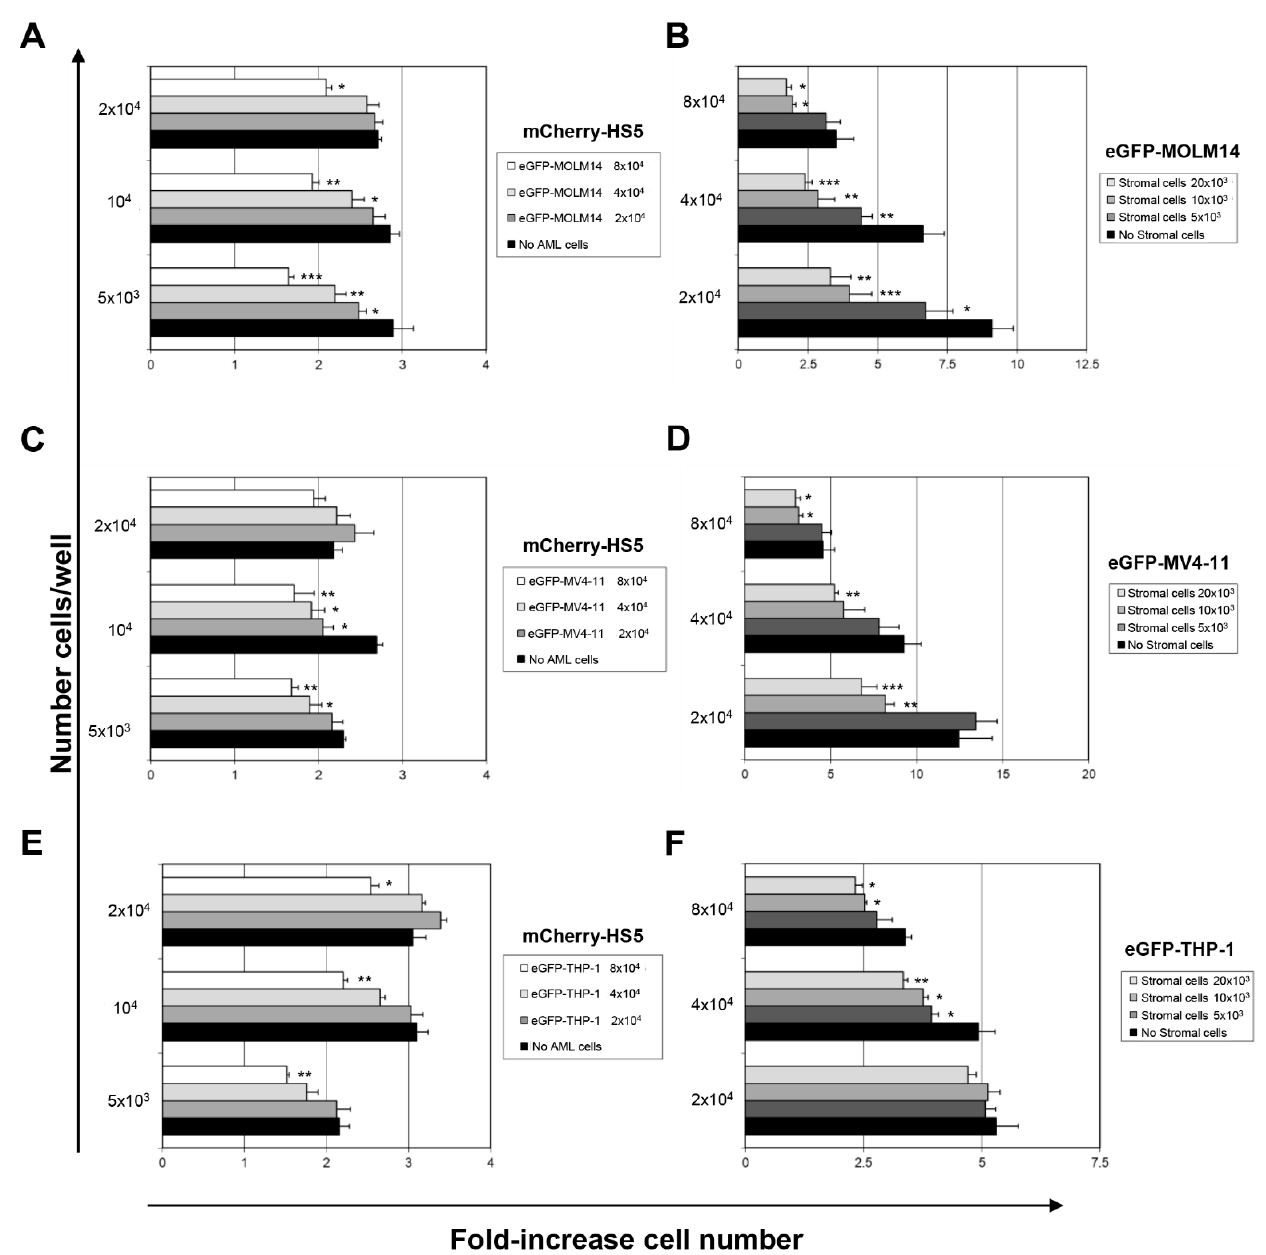
Figure 2. Analysis of stromal and tumour cells’ proliferation in co-culture. Fluorescent-based analysis of proliferation of mCherry-HS5 stromal cells ( A , C , E ) and eGFP-AML cell lines ( B , D , F ). Proliferation of cells was evaluated after 72 h. Histograms indicate the fold-increase in cell numbers. * p < 0.05; ** p < 0.01; *** p < 0.005; ANOVA test versus cells cultured alone.